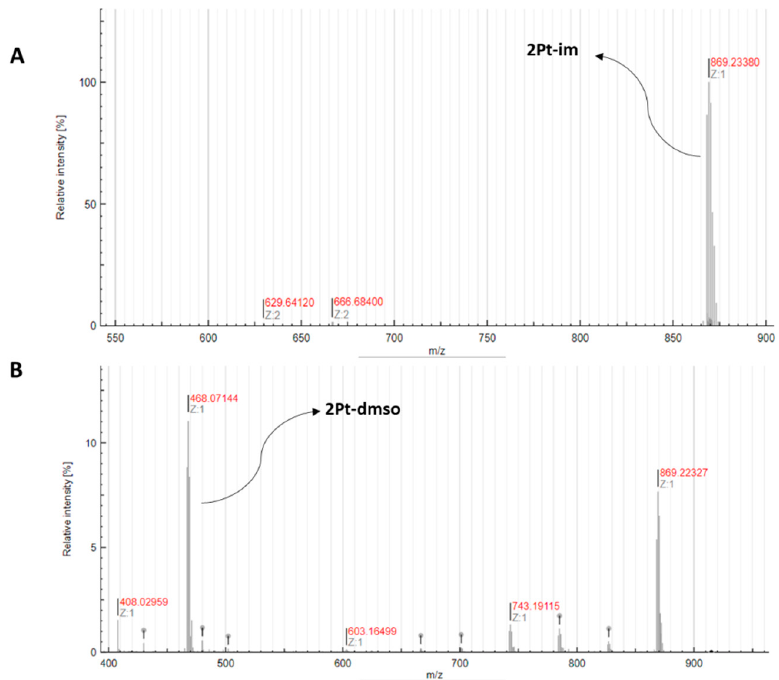
Figure 12. ESI-MS spectrum of 2Pt-im incubated with dGMP in 9:1 v/v H 2 O:DMSO recorded at t = 0 ( A ) and after 48 h at 37 °C ( B ).